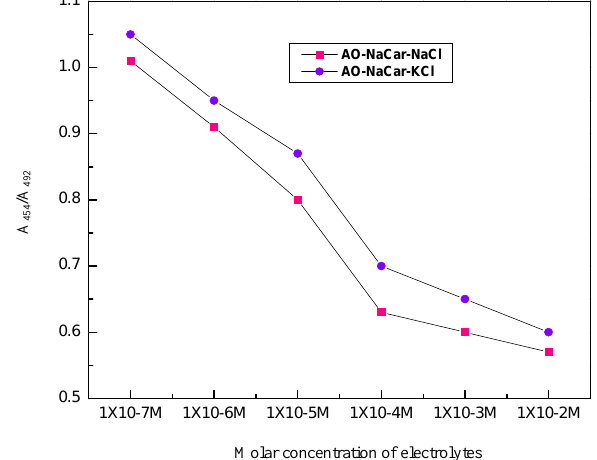
Figure 13. Reversal of metachromasy in AO-NaCar system on addition of electrolytes